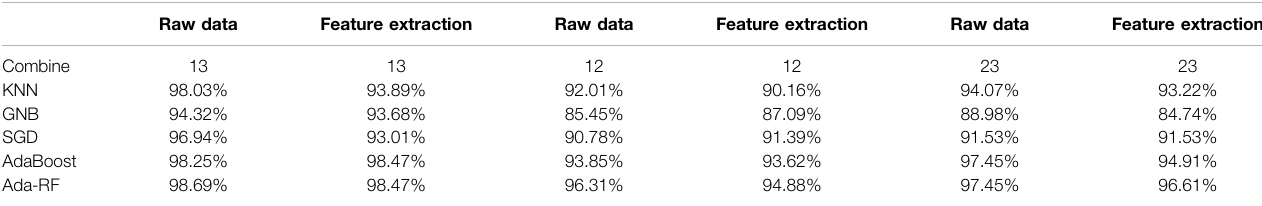
TABLE 5 | Classi fi cation accuracy table of data sets on different models.